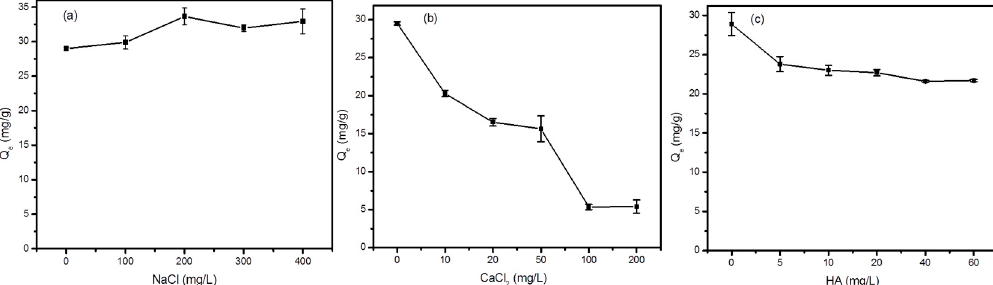
Figure 6. Effect of coexisting Cl − ( a ), Ca 2+ ( b ), and humic acid ( c ) on BPA adsorption onto Mag-PVP (BPA concentration = 10 mg/L; adsorbent dosage = 0.2 g/L; shaking time = 4 h). Error bars represent standard deviation values from three replicates.